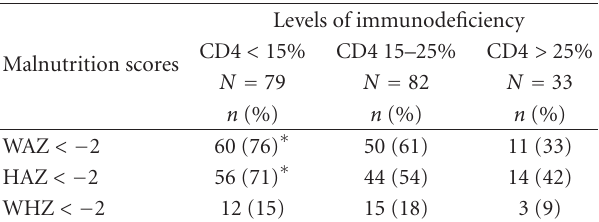
Table 4: Prevalence of underweight, stunting, and wasting at di ff erent levels of